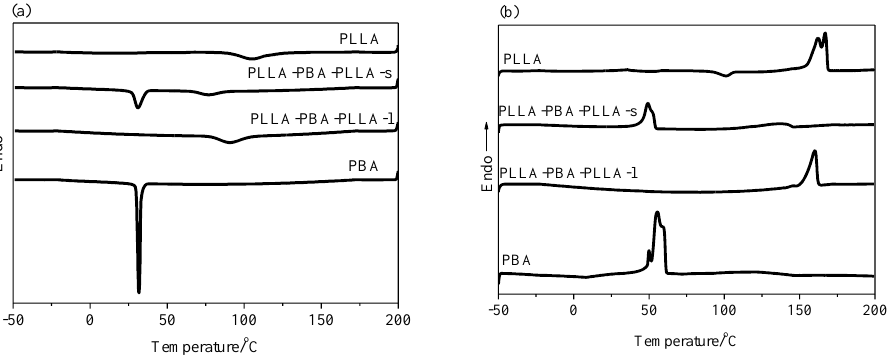
Figure 3. ( a ) DSC cooling curves at a scanning rate of 10 ◦ C/min and ( b ) heating curves of PLLA, PBA, PLLA-PBA-PLLA-s, and